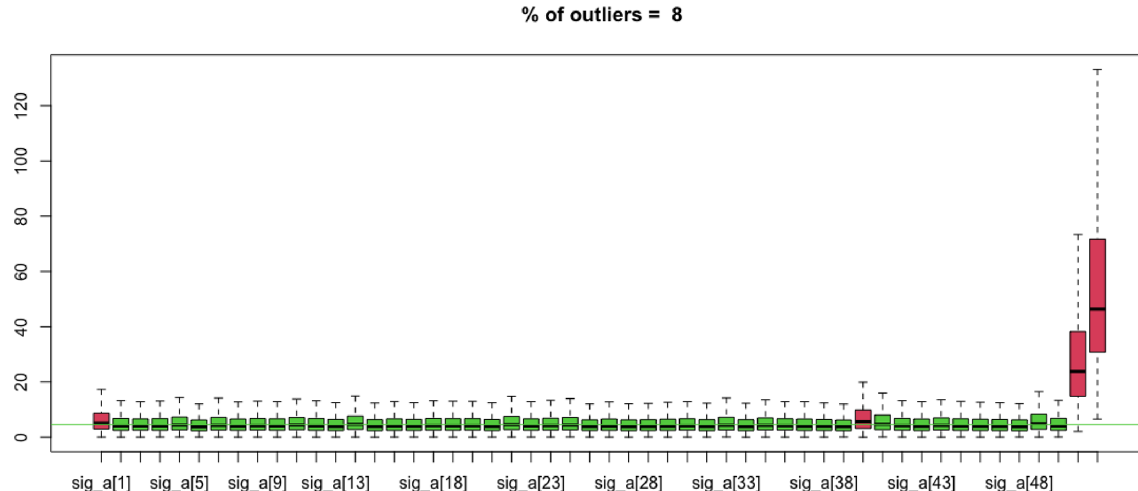
Figure 4. Characterization of the D e values: the values in red are identified as outliers.